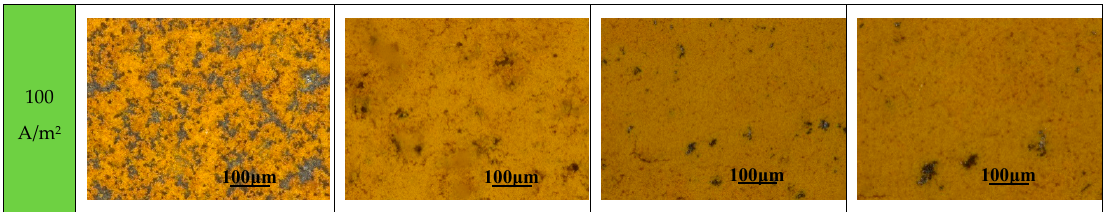
Figure 6. Optical view of the corrosion products on the tops of U-bend specimens after immersion for different time.